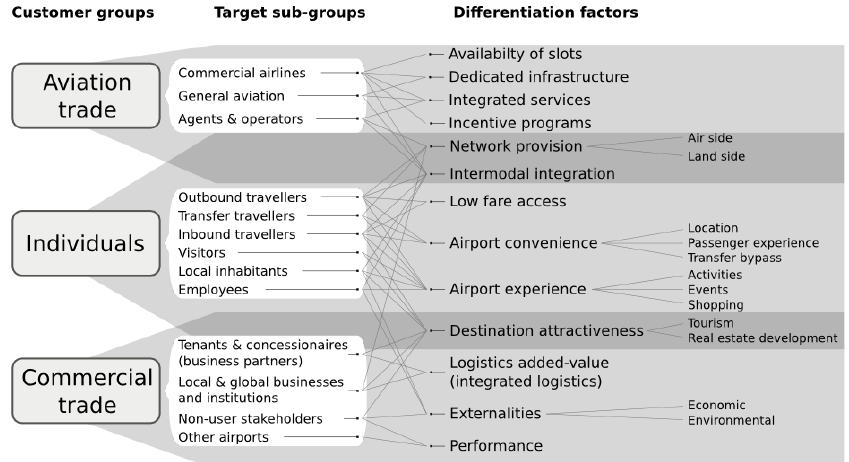
Figure 4 - Differentiation factors for